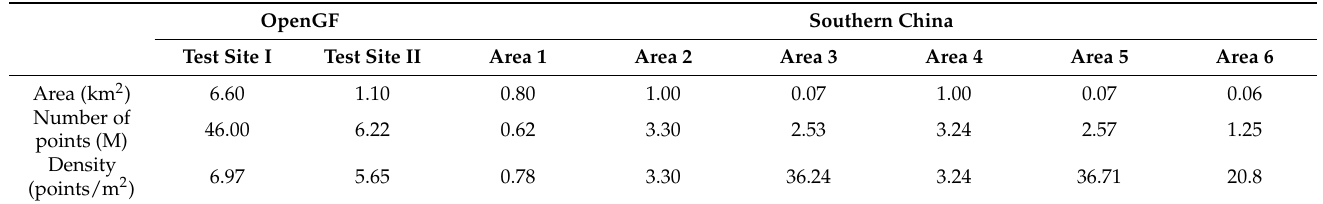
Table 1. Statistical information about the test sites of OpenGF dataset and Southern China dataset. Southern